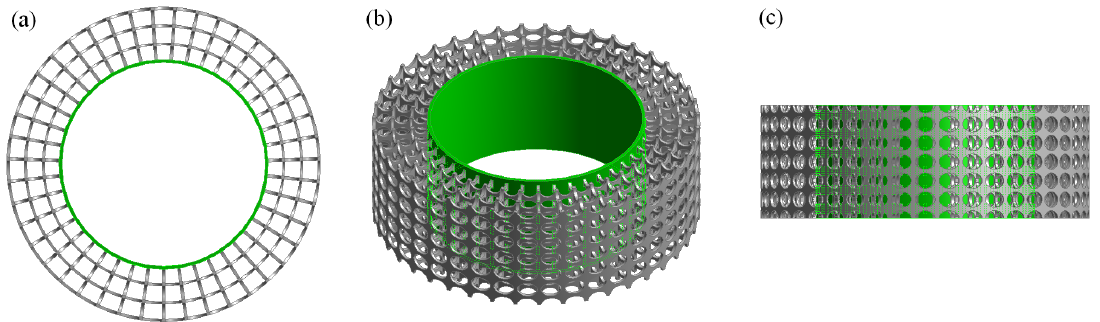
Figure 4. CAD images of the SPCC revealing the LOS in the ( a ) spanwise direction and ( b , c ) radial direction. The inner cylinder is illuminated in a green shading to help visualize the radial LOS in images ( b , c ). The images are rotated about the horizontal axis (i.e., the flow direction) from ( a ) to ( c ). The CAD model and images are created using ANSYS Workbench